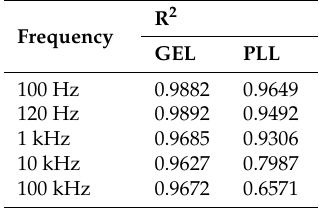
Table 1. R 2 values for mean cell impedance responses in gel and polylysine (PLL) matrices after application of